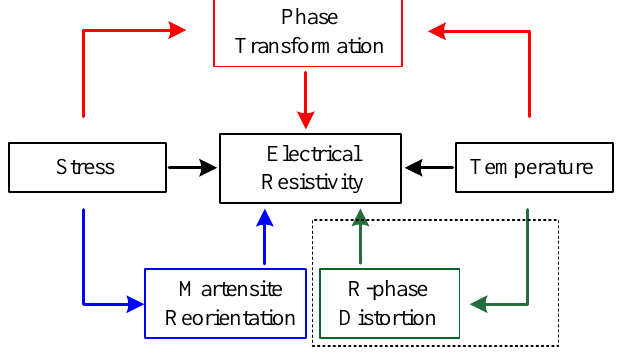
Figure 2. Relationship of influencing factors on ER variation of SMA